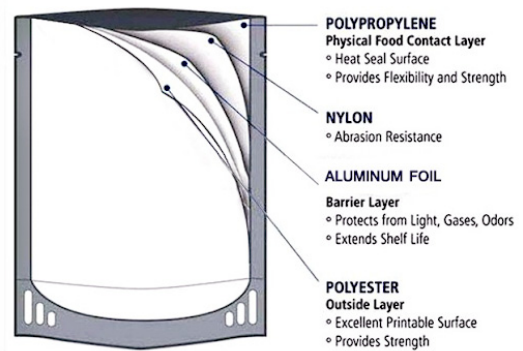
Figure 5. Retort multilayer pouch (Flair Packaging) [146].